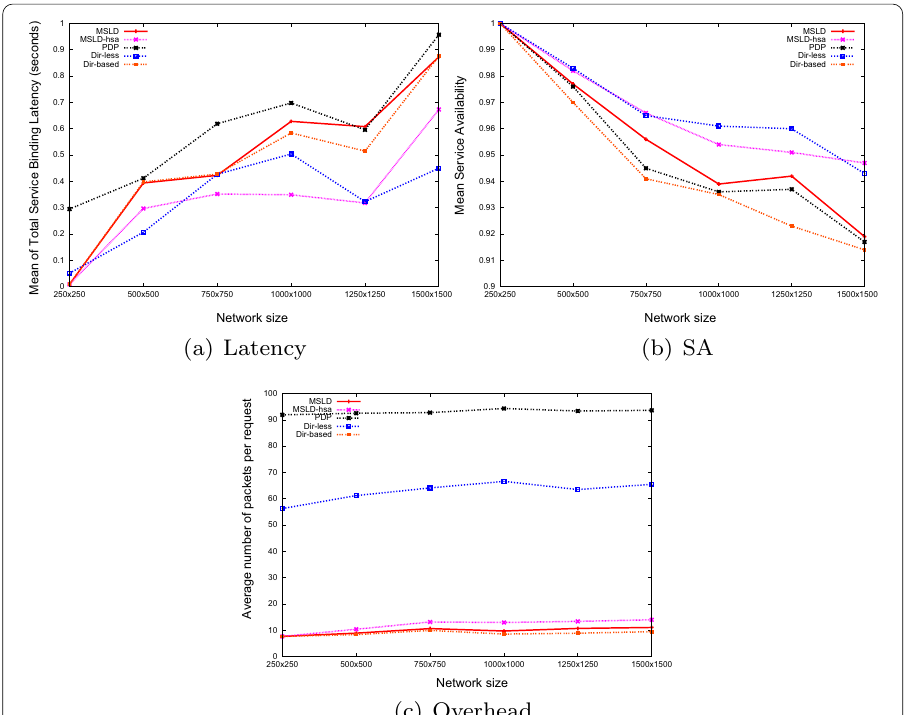
Fig. 2 SD protocols performance versus network density. Figure shows that the performance results were consistent across all SD protocols and showed that decreasing the network density has a negative impact on all protocols in terms of the Mean latency, the Mean SA, and the message